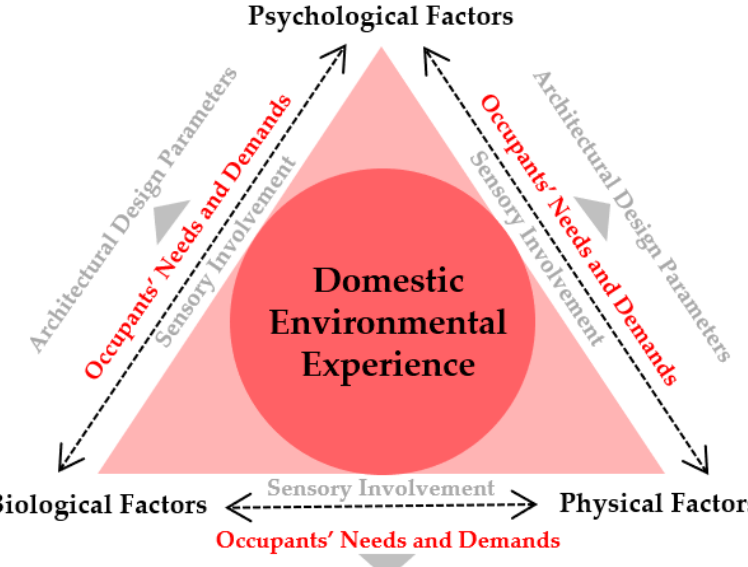
Figure 10. Thematic diagram of ‘domestic environmental experience’. Modified from Source: [4,43].